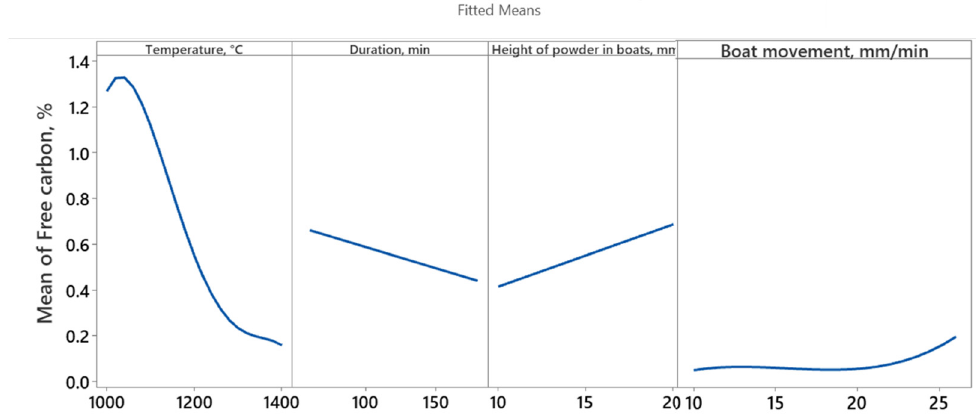
Figure 4. Main effect plots for the free carbon content in WC after the carbidization in the furnace.